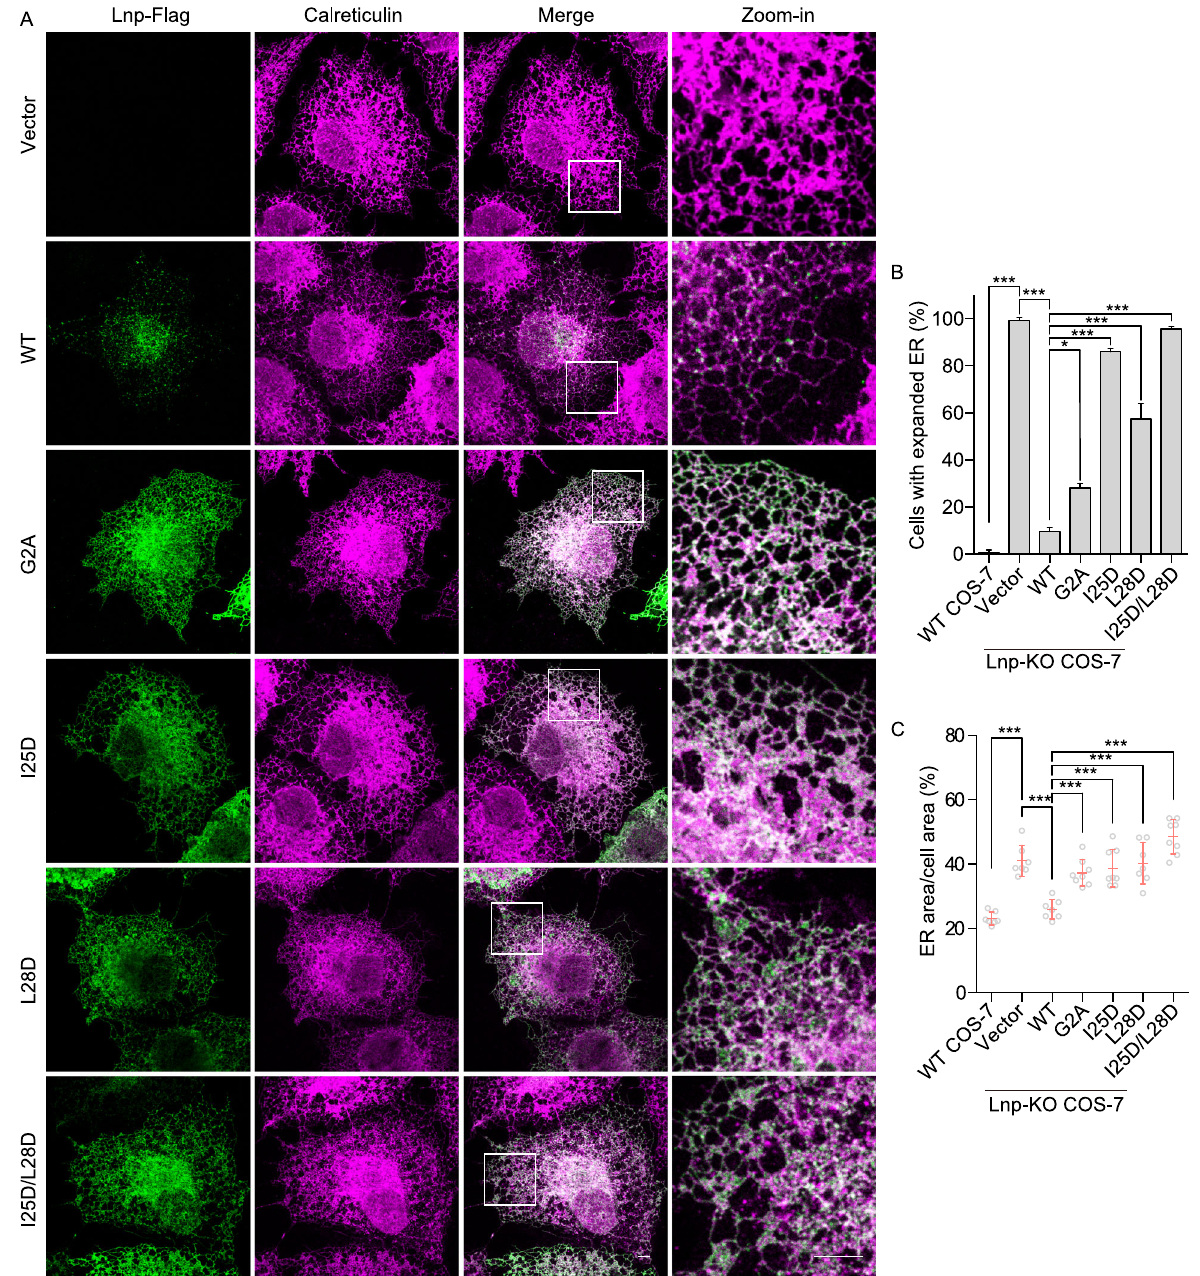
Figure 3. ER morphology rescue assays in Lnp-deleted COS-7 cells. (A) Flag-tagged wild-type Lnp and the indicated mutants were expressed in Lnp-deleted (Lnp-KO) COS-7 cells. Their localization was determined by anti-Flag antibodies (green). The ER morphology was visualized by indirect immunostaining of endogenous ER luminal marker calreticulin (magenta). Scale bars = 5 μ m. (B) Percentage of cells with expanded ER in (A). Columns are shown in mean ± SD. A total of 50 to 60 cells were categorized for each sample. Cell numbers were counted in three independent experiments. * P < 0.05; *** P < 0.001 by Fisher ’ s exact test. (C) The ratio of the ER area to the cell area in (A). Data are shown in scatter dot plot with mean ± SD. The cell area and corresponding ER area were measured and analyzed by Image J. 8 to 10 cells in each sample were analyzed. *** P < 0.001 by Mann-Whitney